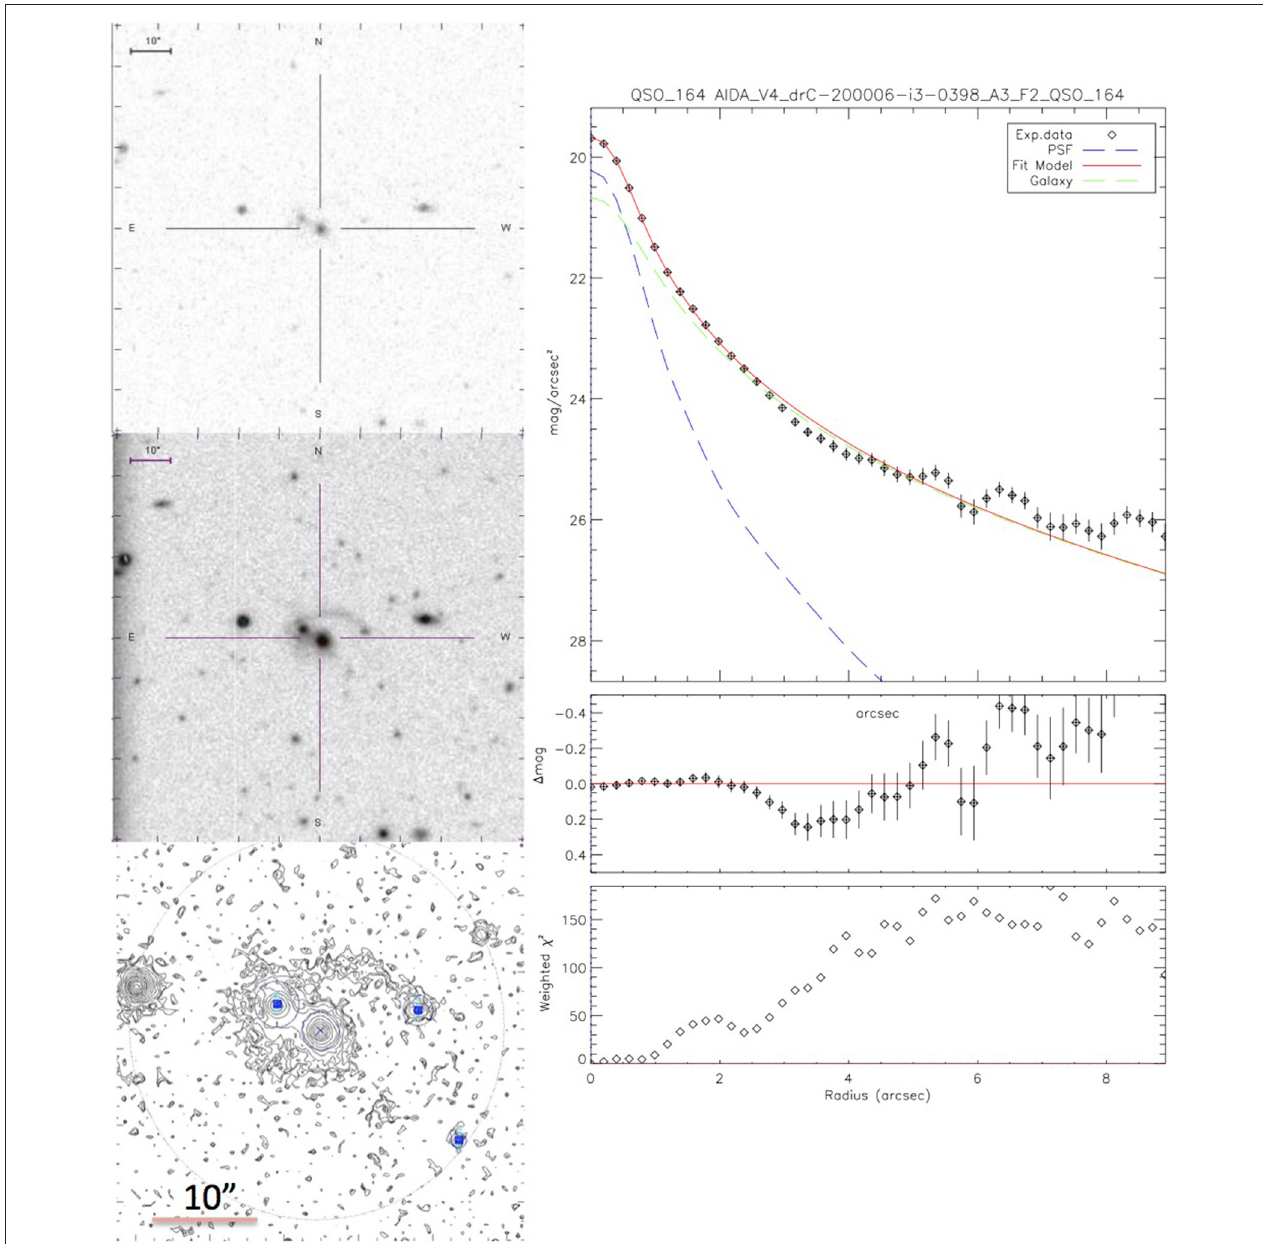
FIGURE 1 | Upper left: SDSS-DR7 i-band image, middle left: corresponding data from Stripe 82, bottom left: contour plot zoomed on the central object of the Stripe 82 i-band image (north at top, east left). Upper right: i-band radial profile together with the AIDA decomposition and fit. Middle right: distribution of residual for the best fit. Lower right: distribution of χ 2